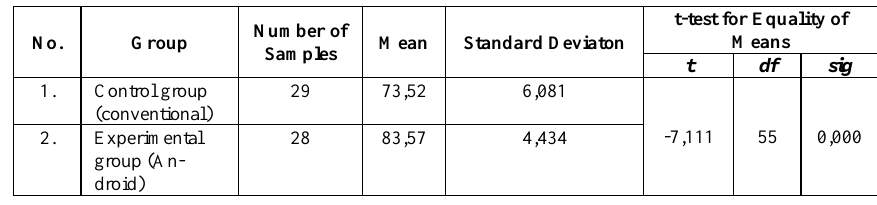
Table 2. Summary of t-test